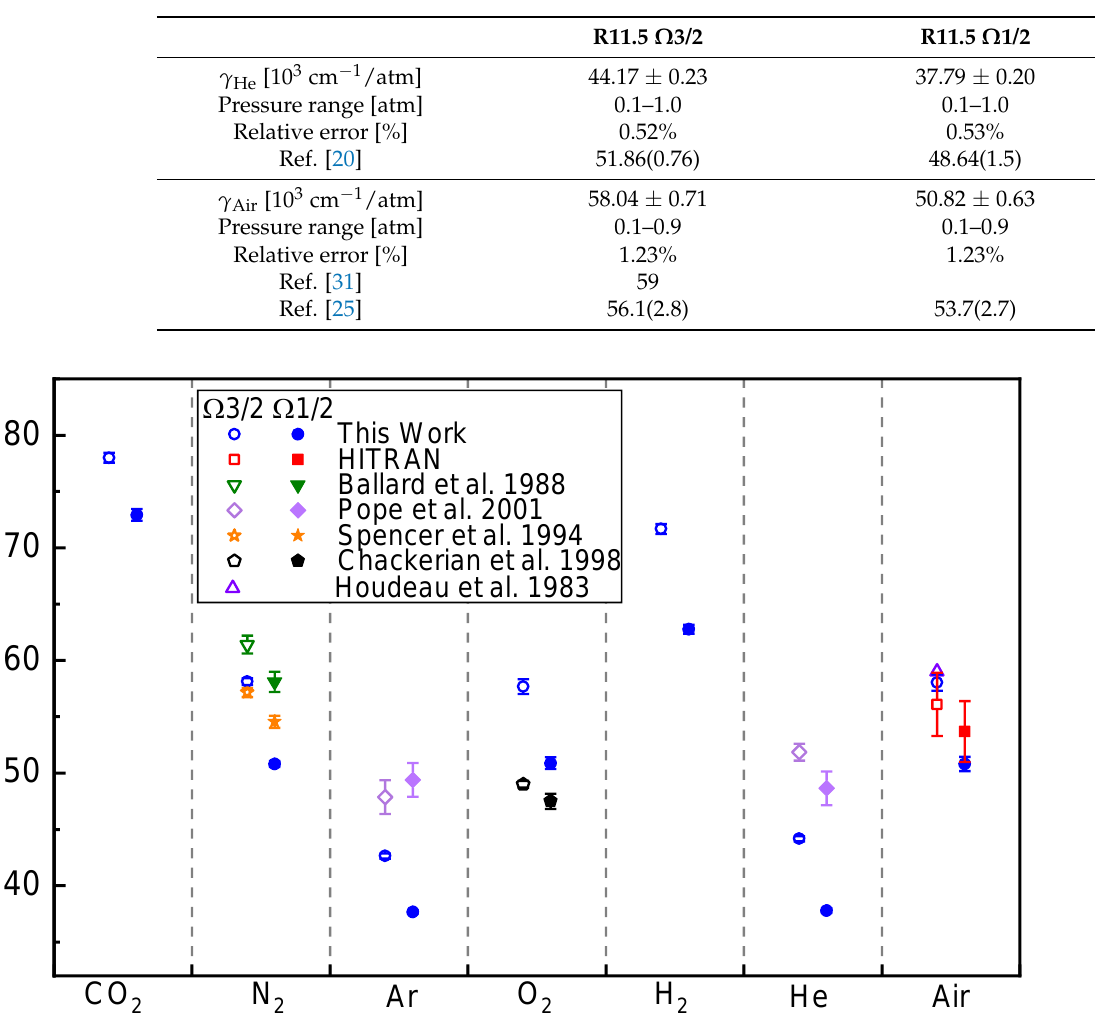
Figure 8. Comparison of our findings to published data from the literature. Solid points: R11.5 Ω3/2, Open points: R11.5 Ω1/2. [20,28 – 31]. Table 2. Comparison of our findings with information from the literature regarding the NO (1 ← 0) R (11.5) absorption lines ’ broadening coefficients when combined with N 2 , CO 2 , Ar, H 2 , O 2 , He, and Air.